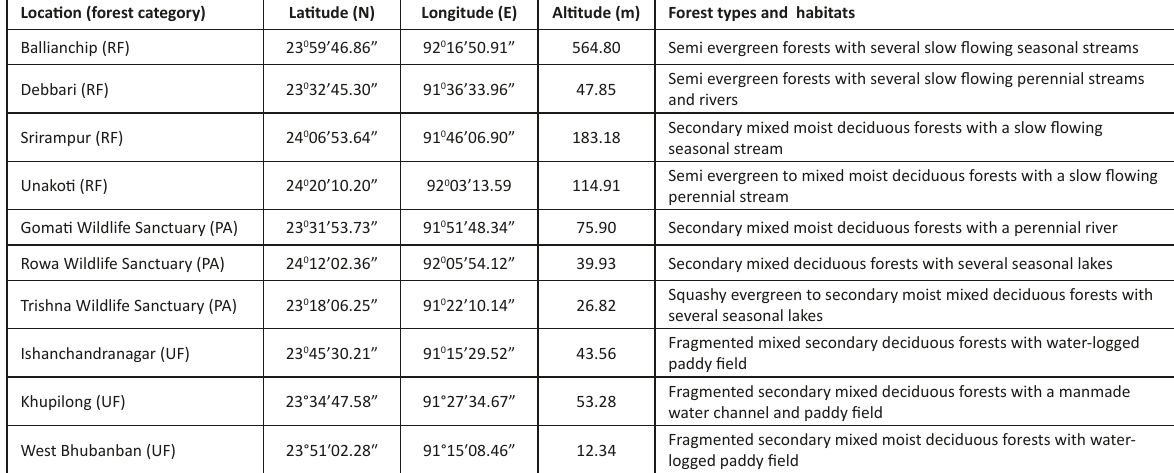
Table 1. Data of geo-coordinates, major forest types and habitats of the study locations. Location (forest